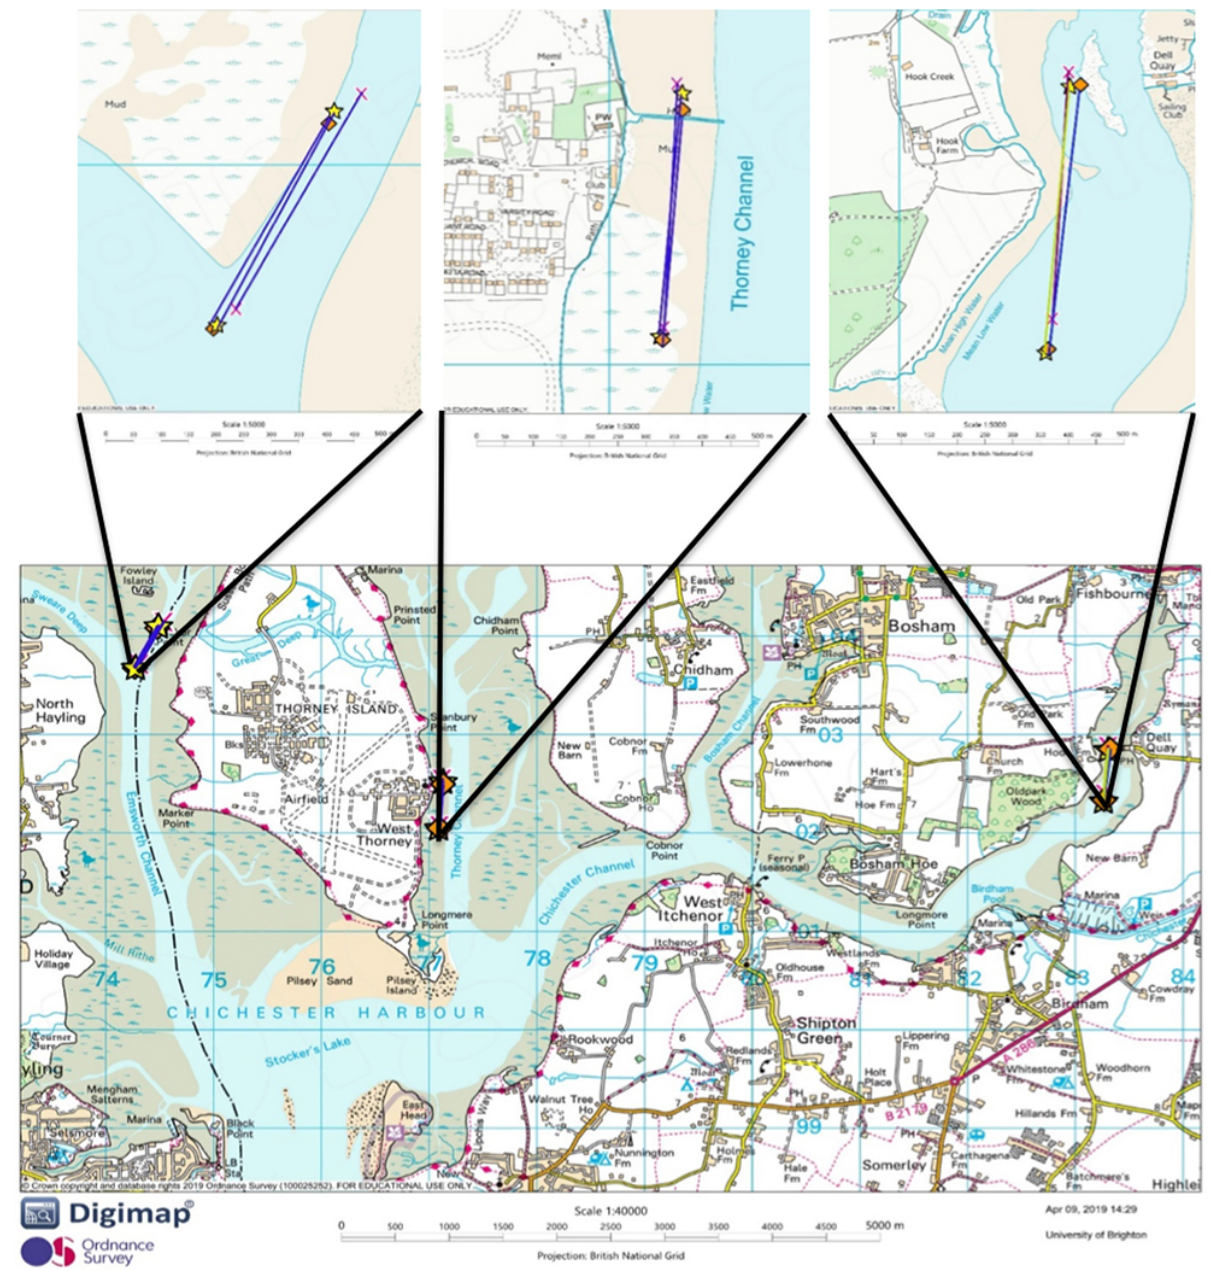
Figure 1. Map of Chichester Harbour, East Sussex, U.K. showing the 3 sampling locations. Insets from left to right show locations sampled in Emsworth Channel, Thorney Channel and Dell